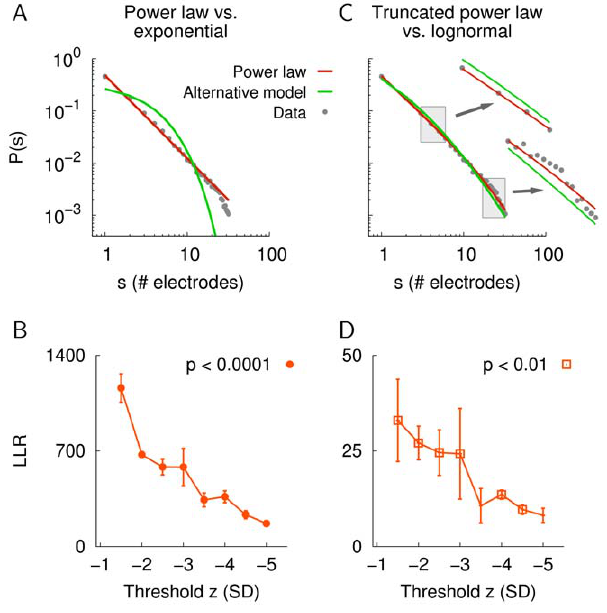
Figure 4. Model comparison using the LLR test. A. Model fits obtained by ML estimation for the power law (red) and the exponential model (green) for the cluster size distribution in monkey X. B. LLR values for increasing threshold, z . Error bars denote the SD across the decorrelated sub-sets of the data. All LLRs were positive and statistically different from zero ( p , 0.0001). The avalanche lags ranged from 10 ( z = 2 1.5) to 2 ( z = 2 5). C and D. The same for the comparison between the exponentially truncated power law (red) and the lognormal distribution as the alternative model (green). The insets show detailed views of the distributions, corresponding to the respective gray rectangles. The square symbols in (D) indicate the LLR values that were statistically different from zero ( p , 0.01).